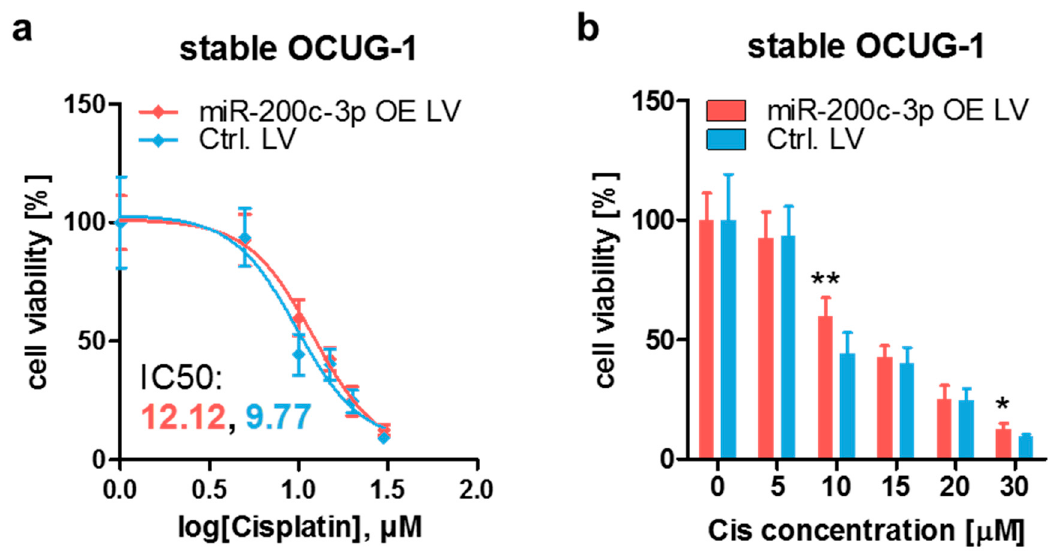
Figure 4. Stable miR-200c-3p overexpression results in an increased cisplatin resistance in OCUG-1 cells. ( a ) IC50 determi- nation and ( b ) direct comparison of stable miR-200c-3p overexpression OCUG-1 cells (miR-200c-3p OE LV) and OCUG-1 control cells (Ctrl. LV). Cells were treated with various concentrations of cisplatin (Cis). After 48 h, cell viability was assessed by adding WST-1 reagent and measuring the absorbance at 450 nm and 620 nm (reference wavelength). Cells treated with cisplatin were normalized to untreated (0 μ M) cells (set to 100%). ( a ) Ordinary least-squares regression with outlier removal following the ROUT method was used to determine the IC50 values of the respective cells. ( b ) Unpaired two-tailed t-test was used to evaluate statistical significance. * p < 0.05, ** p < 0.01.